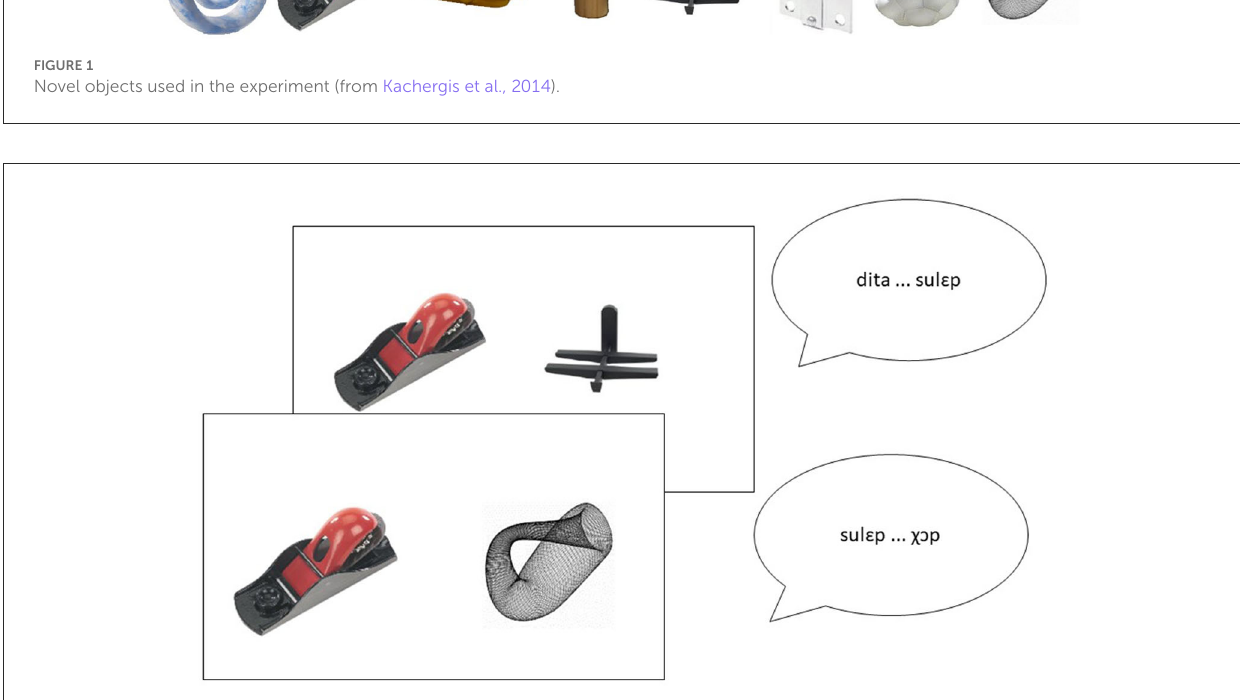
FIGURE2 Two familiarization